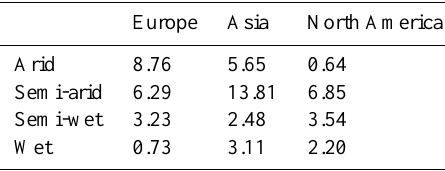
Fig. 7. The regional contribution of land-surface linear air tempera- ture trend to global as function of climatological mean precipitation. The precipitation interval is 100mmyr − 1 . The result of the regions which climatological mean precipitation is larger than 2000mm are omitted due to smaller contribution rate.